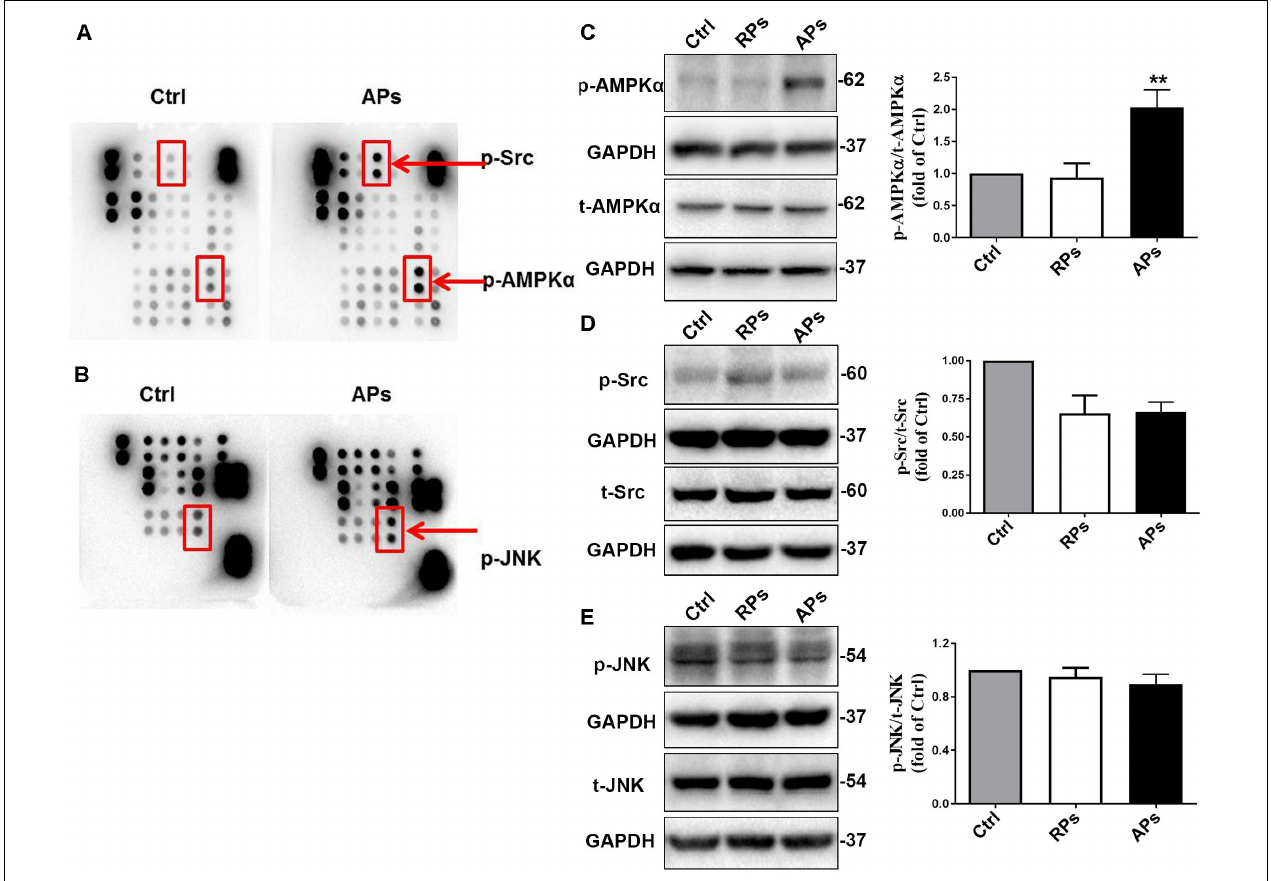
FIGURE 3 | APs activate the AMPK α signal pathway to suppress VSMC proliferation. (A,B) The phosphorylation of AMPK α , Src and Jun were assessed by proteomics analysis of phosphokinase arrays in control (Ctrl) VSMCs and APs cocultured with VSMCs. The phosphorylation of (C) AMPK α , (D) Src, and (E) Jnk was determined with western blot analysis in control (Ctrl) VSMCs, RPs, and APs cocultured with VSMCs. Data are presented as mean ± SD ( n = 6). Comparisons between more than two groups were analyzed using one-way ANOVA analysis with the Dunnett’s multiple correction. ** P < 0.01 vs Ctrl (VSMCs without